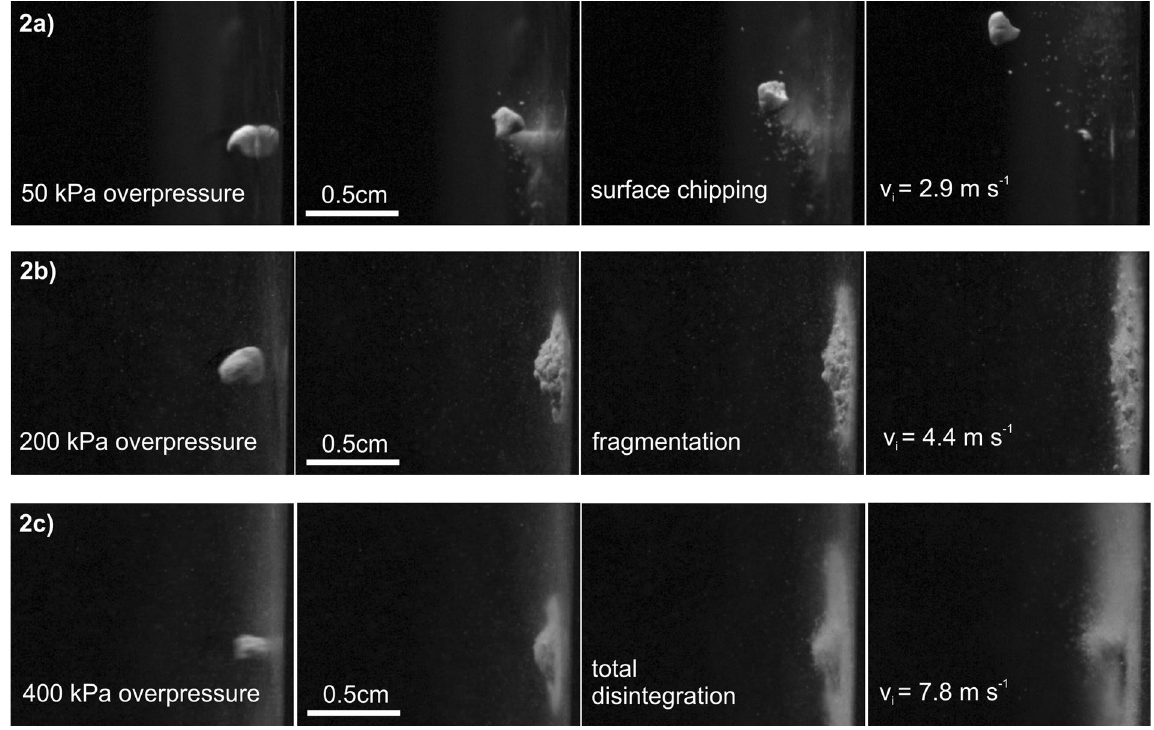
Figure 2. Sequence of photos taken with a high-speed camera; aggregates impact on metal wall of the Aarhus setup. ( a ) Sequence shows surface chipping of aggregate, ( b ) fragmentation and ( c ) total disintegration.